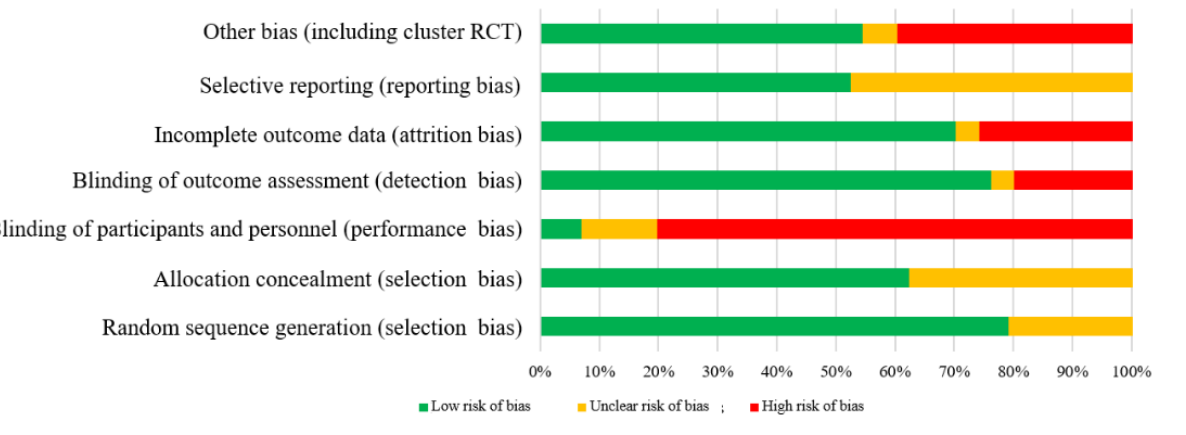
Figure 10. Summary of the overall risk of bias assessment for included studies. RCT: randomized controlled